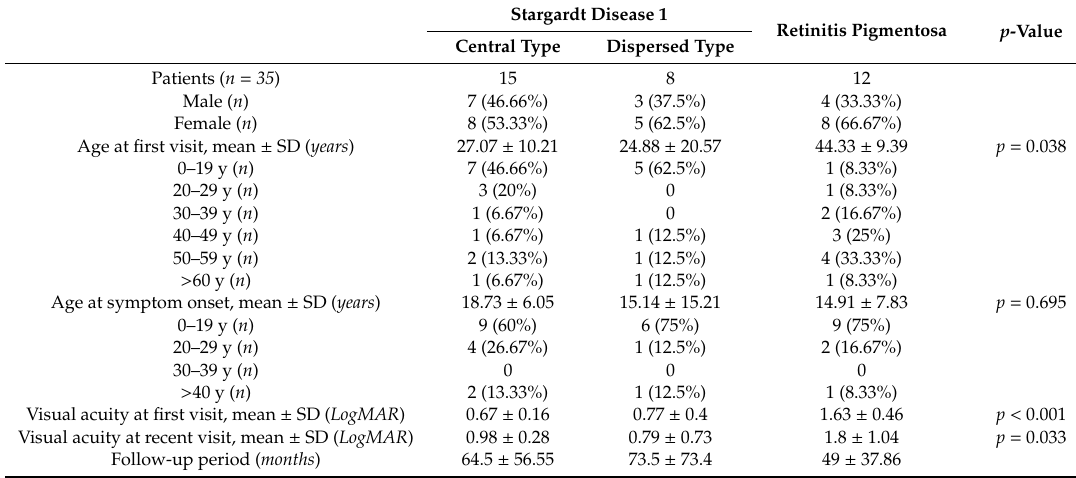
Table 1. Demographic data of the ABCA4 -associated Stargardt disease 1 (STGD1) and retinitis pigmentosa (RP)